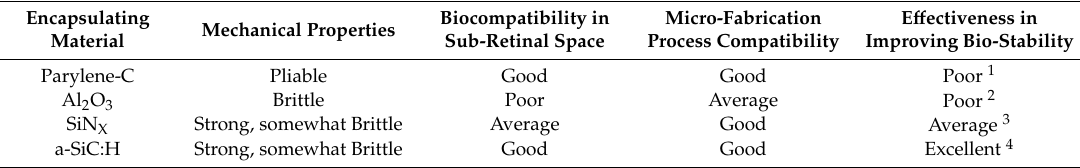
Table 2. Comparison of properties of potential encapsulating materials for micro-fabricated, implantable retinal prosthesis components to improve long-term